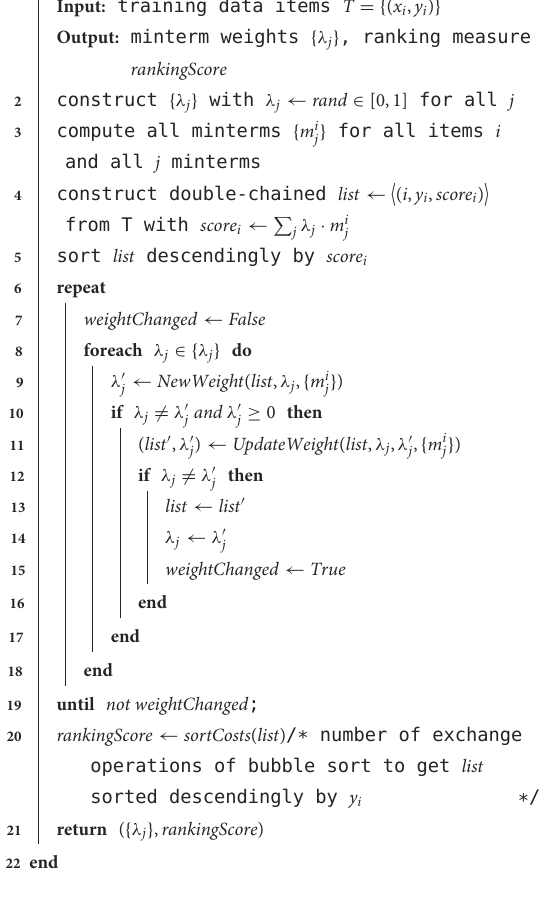
Algorithm 1. Generates all minterm weights { λ j }